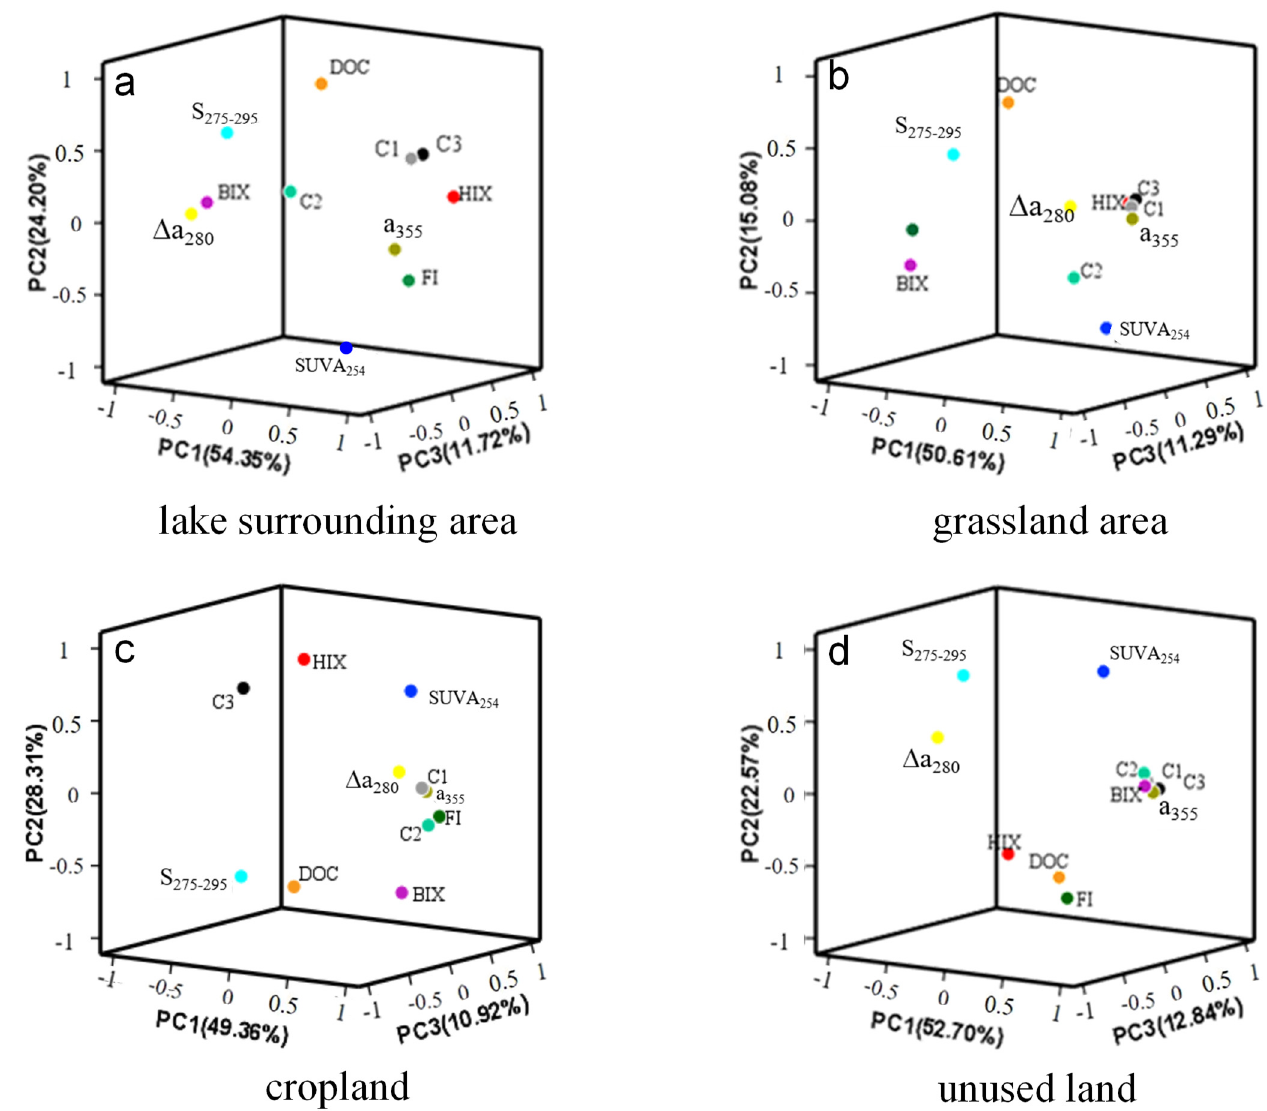
Figure 6. PC1 and PC2 loadings of DOM, and PC1 and PC2 scores for different samples. Positive and negative numbers on axes indicate the correlation coefficients which are positive or negative. ( a ): lake surrounding area; ( b ): grassland area; ( c ): cropland; ( d ): unused